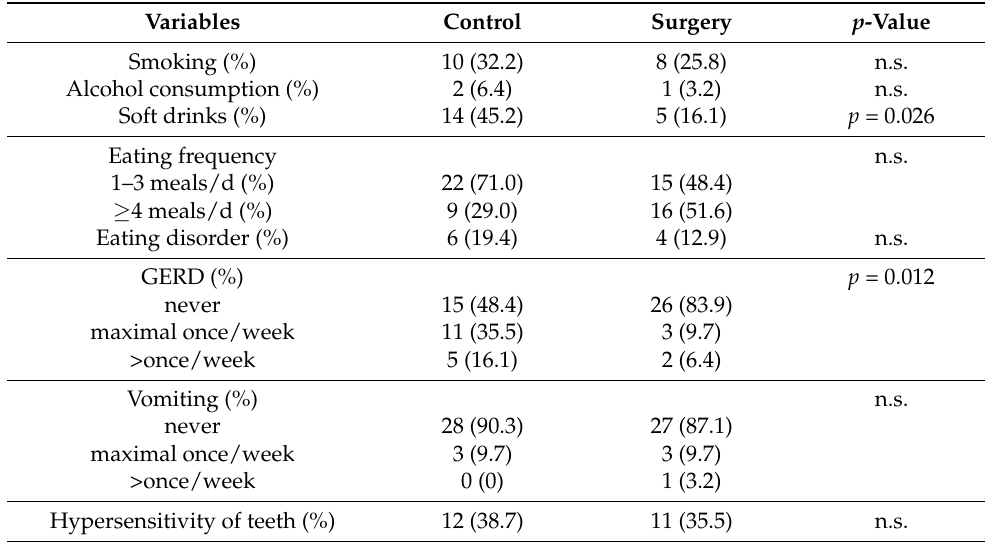
Table 3. Oral health related